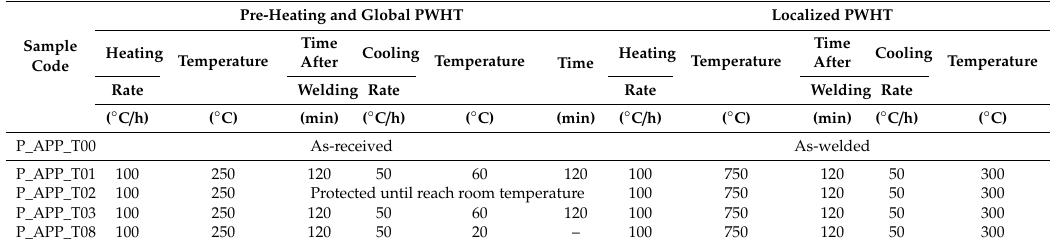
Figure 1. Different sets of thermal cycles used for each set of samples utilized in this work. Legend: ( a ) Pre-heating; ( b ) Welding; ( c ) Post-heating; ( d ) Transformation time; ( e ) Controlled cooling; ( f ) Post-welding heat-treatment (PWHT). Table 5. Different thermal cycles applied to the P91 samples.